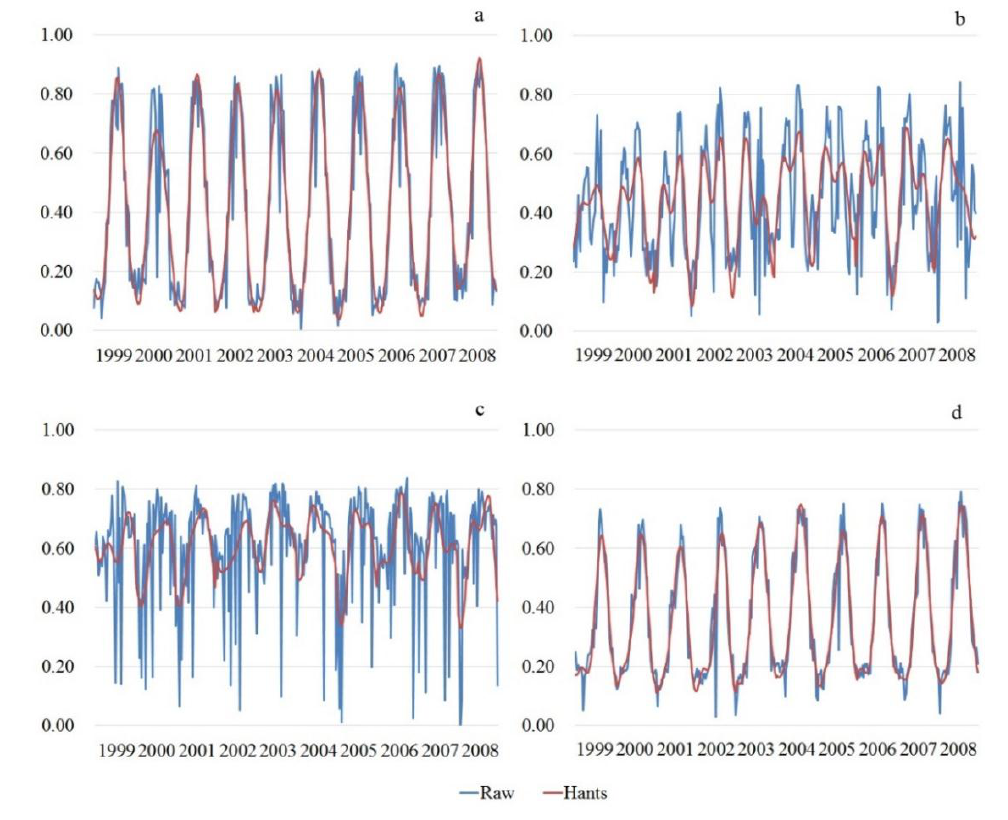
Figure 10. Comparison of raw NDVI and HANTS-filtered NDVI. ( a ) Broadleaf deciduous tree, 129°08′56″E, 45°16′44″N; ( b ) crop, 117°29′35″E, 33°23′10″N; ( c ) needle leaf evergreen tree, 118°52′08″E, 28°30′32″N; and ( d ) grass, 114°47′17″E,